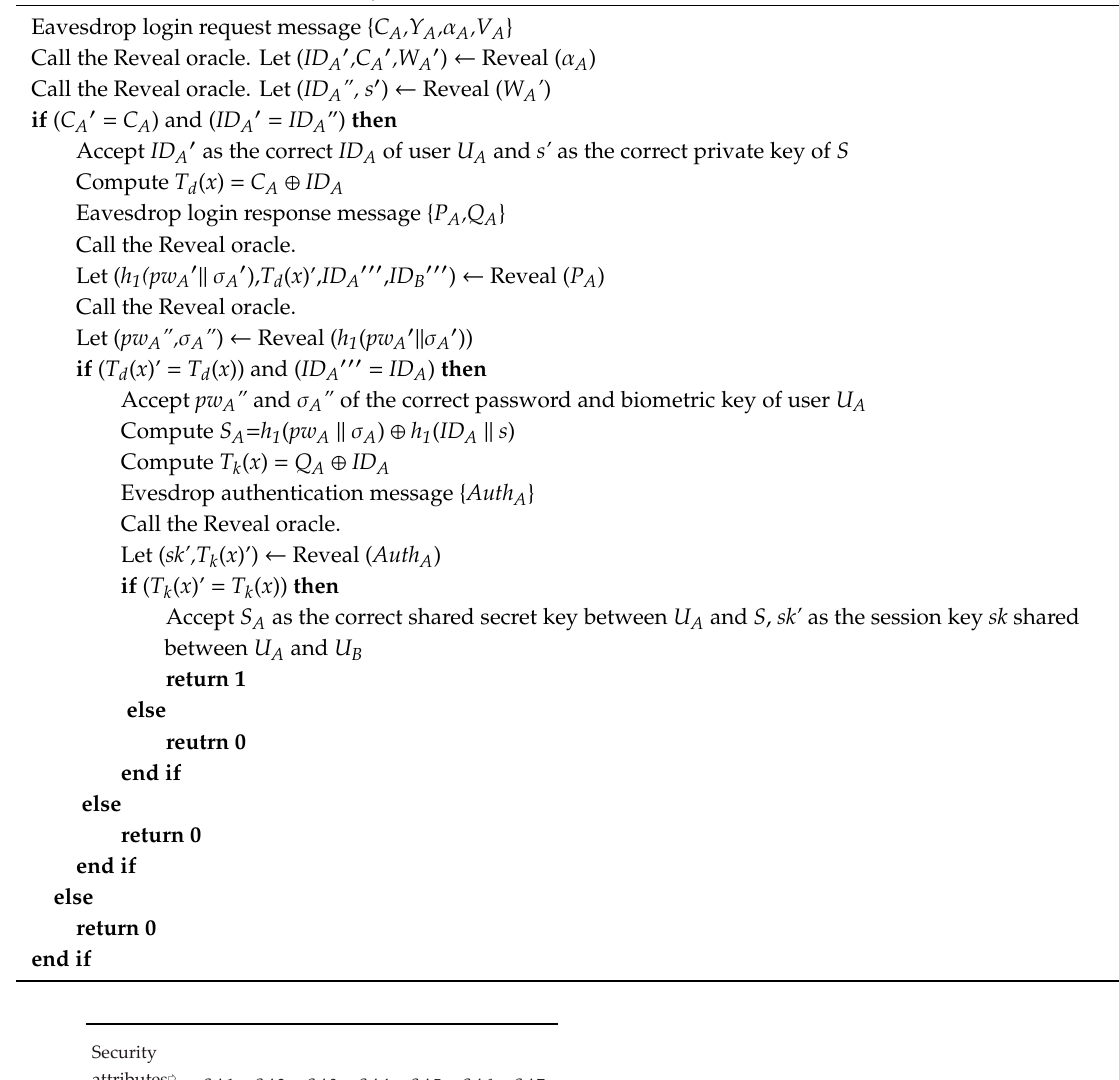
Algorithm 1: Algorithm EXP SBAKE HASH , A Eavesdrop login request message { C A ,Y A , α A ,V A }